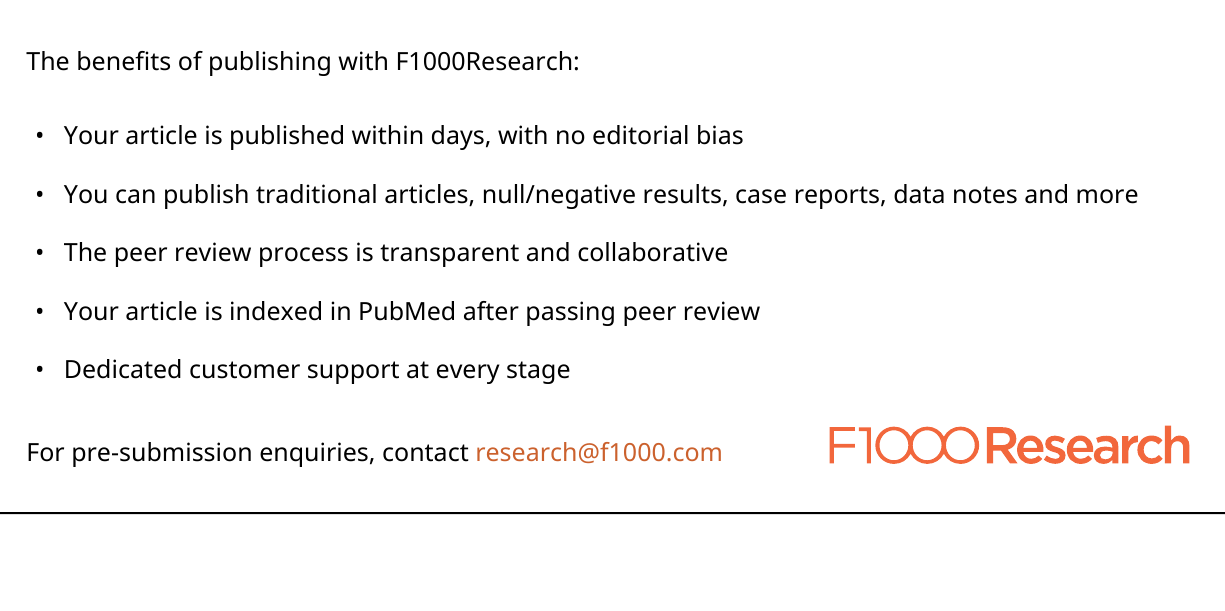
Table 5: The title of this table may be as follows " Insecticide resistance management ○ strategies". Are the rationale for, and objectives of, the Systematic Review clearly stated? Yes Are sufficient details of the methods and analysis provided to allow replication by others? Yes Is the statistical analysis and its interpretation appropriate? Not applicable Are the conclusions drawn adequately supported by the results presented in the